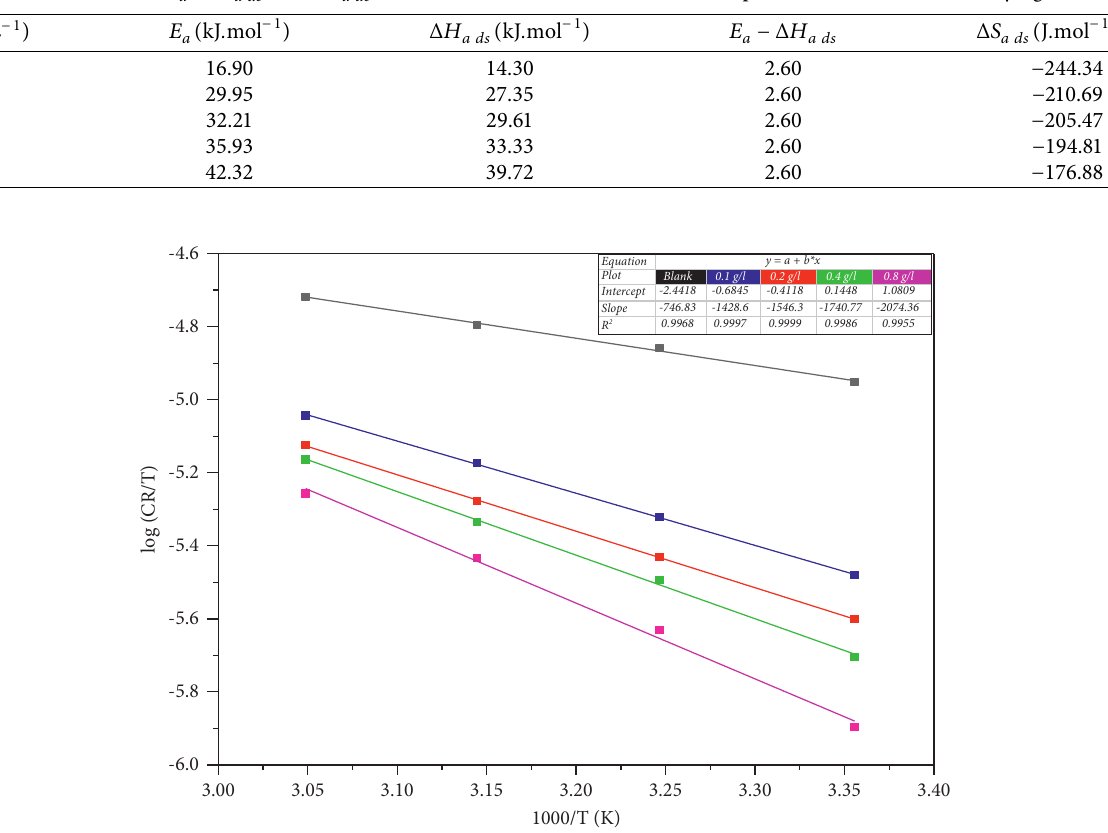
Figure 6: Transition state plot of log (CR/T) vs. 1000/T for carbon steel corrosion in 1M HCl in the absence and presence of EEW.